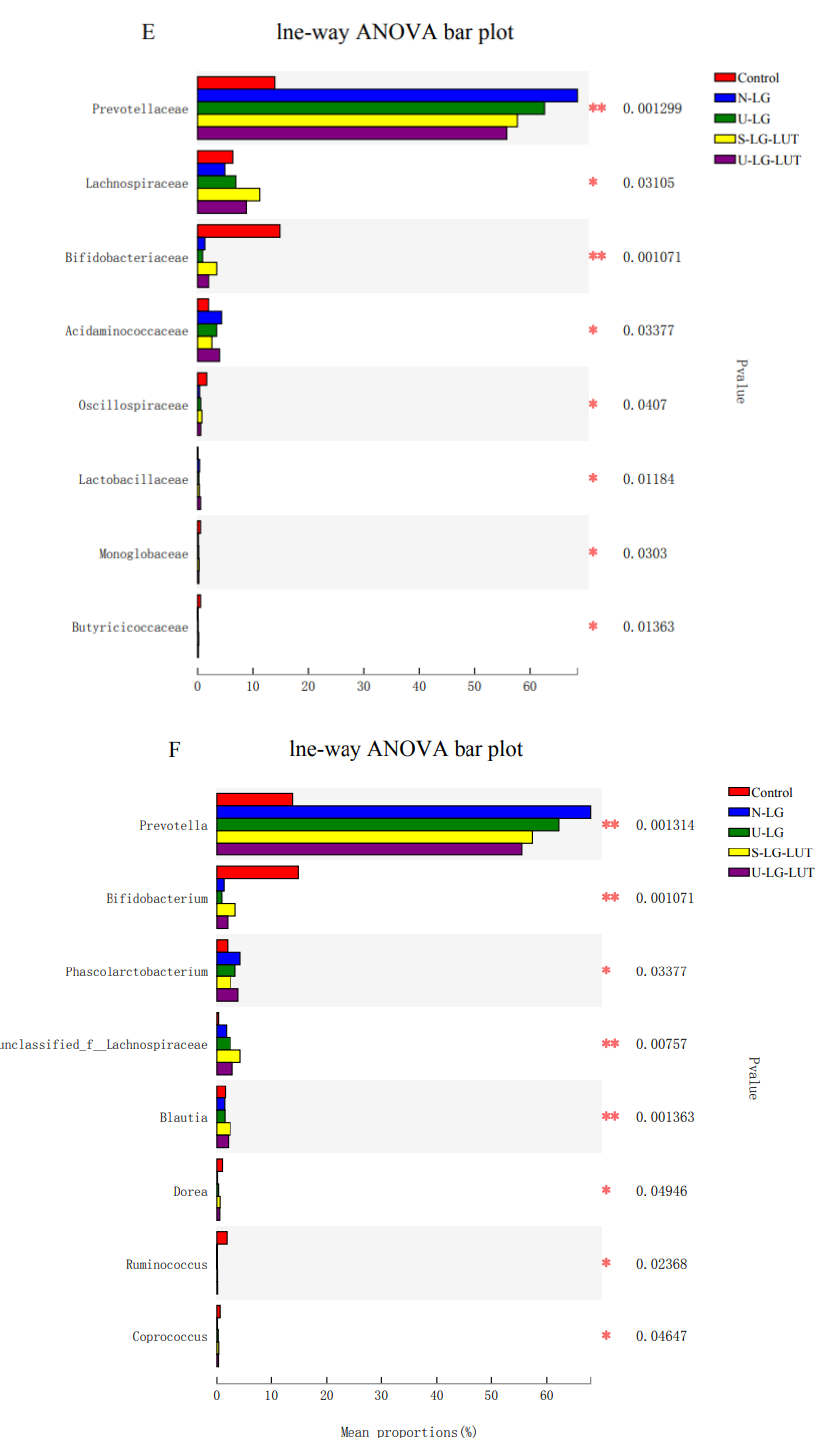
Figure 5. Effect of N-LG, U-LG, S-LG–LUT and U-LG–LUT on the community abundance at the phylum level ( A ), family level ( B ), and genus level ( C ); The one-way ANOVA bar plot of multi groups at the phylum level ( D ), family level ( E ), and genus level ( F ). * and ** symbols indicate significance p < 0.05 and p < 0.01